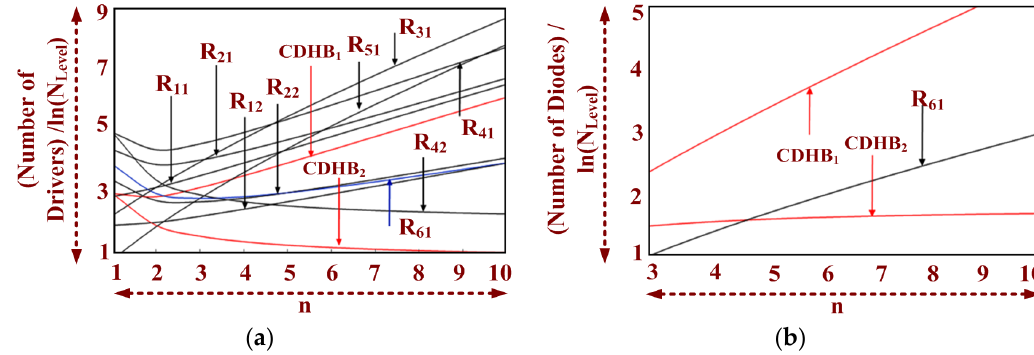
Figure 7. Comparison of proposed topology with various topologies algorithms for ( a ) N driver with constant N Level , ( b ) N diode with constant N Level .